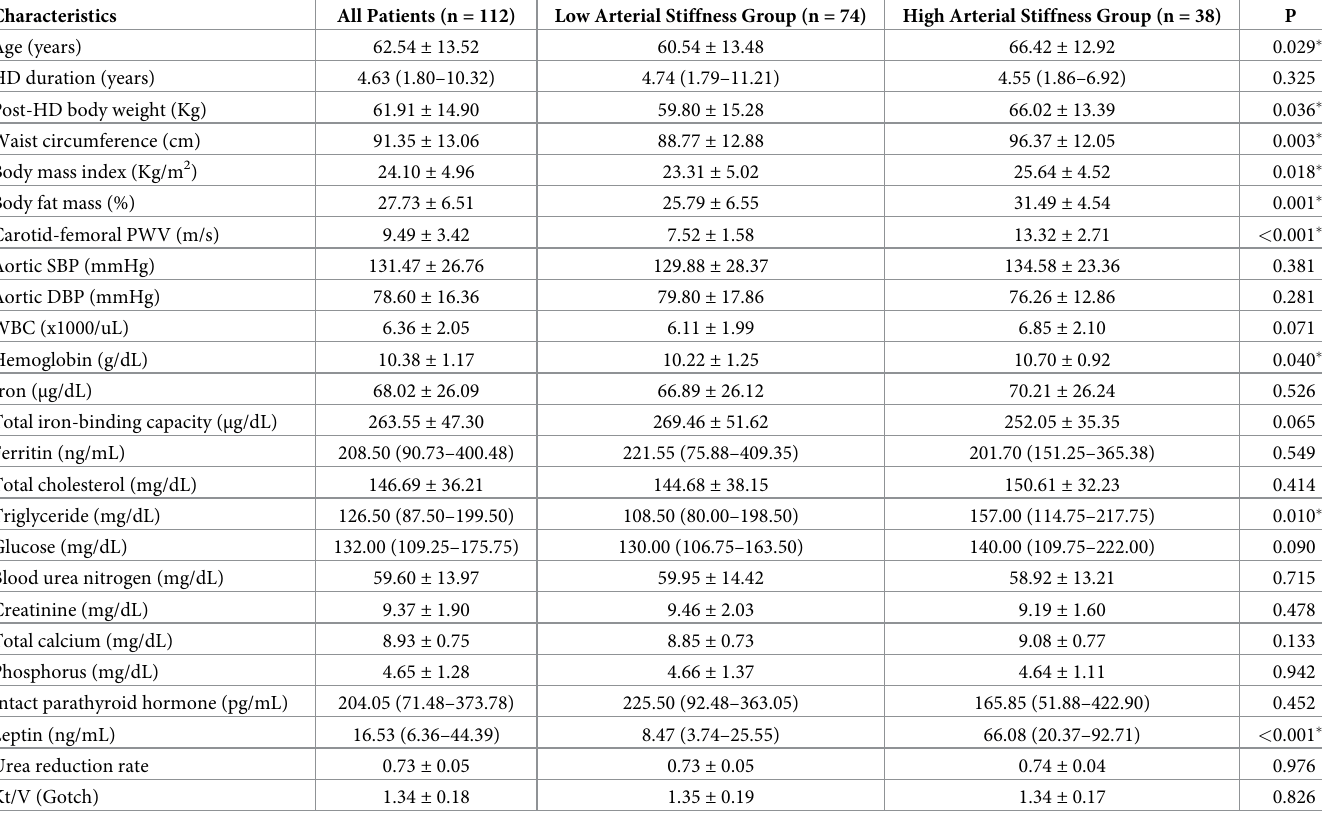
Table 1. Clinical variables of the 112 hemodialysis patients with high or low arterial stiffness.